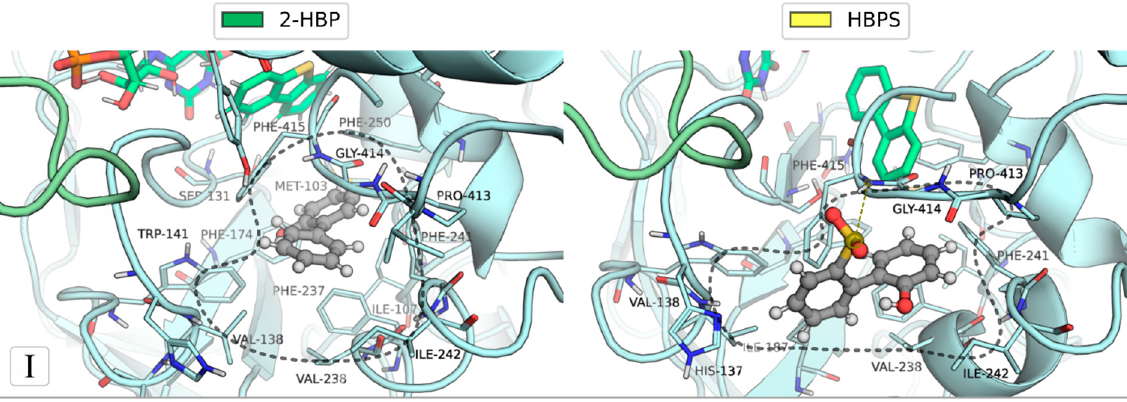
Figure 6. Representative pose of 2-HBP and HBPS at the binding sites I. 2-HBP and HBPS are represented in ball-and-stick representation with carbons colored in gray. All residues composing the binding pocket and those within 4 Å of 2-HBP and HBPS are represented in stick representation. Residues within 4 Å of either 2-HBP and HBPS are labeled. Each monomer of DszC is represented in cartoon and colored green (chain A) or cyan (chain B). Hydrophobic patches are outlined with dashed gray lines, and hydrogen bonds are represented with dashed green lines.